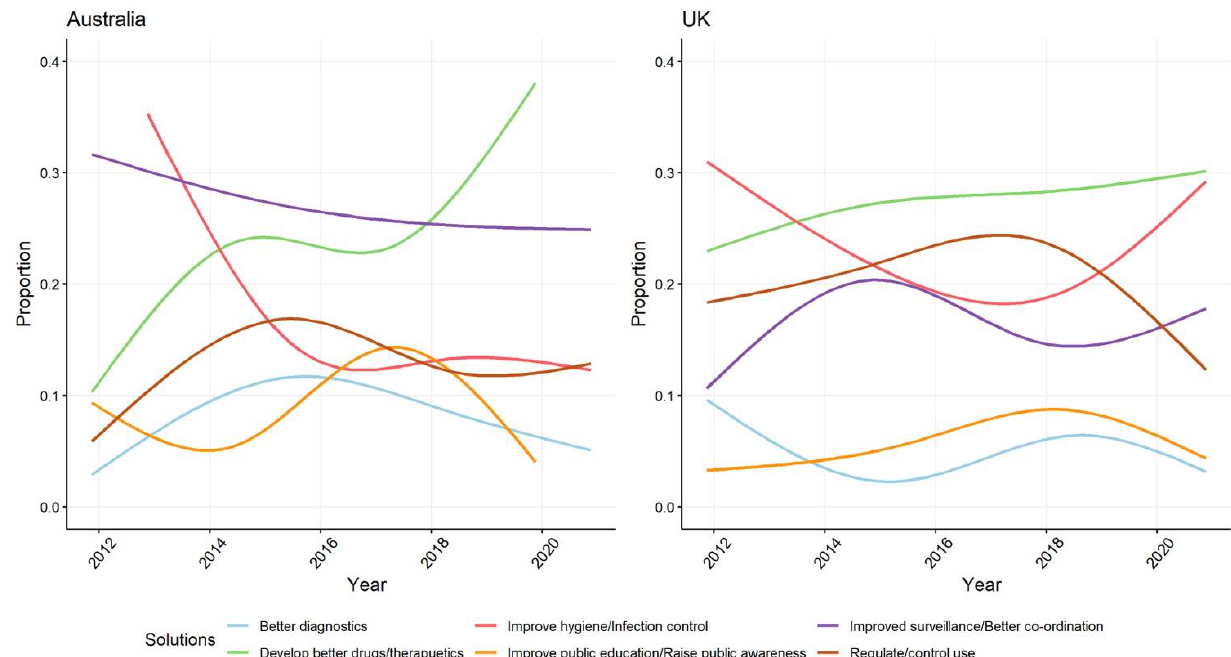
Figure 7. Proportion of different framings in Australian and UK newspapers of possible solutions to the problem of AMR.